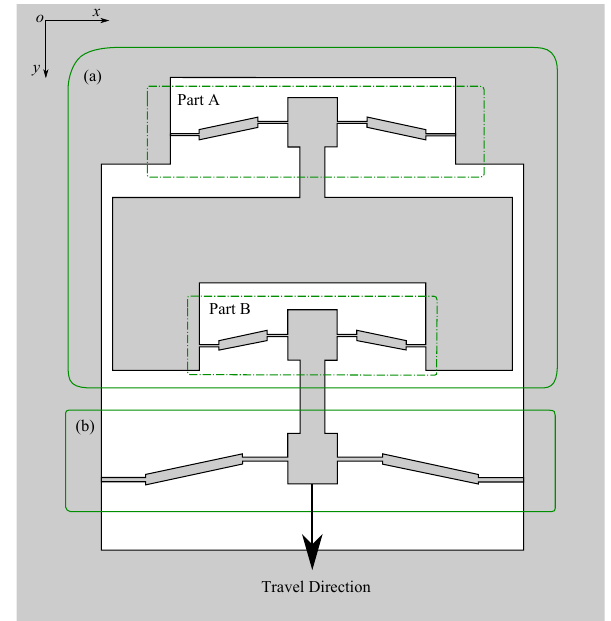
Figure 11. Structure of a fully-compliant statically-balanced mech- anism consisting of three classic fully-compliant bistable mecha- nisms. (a) The compliant tristable mechanism consisting of two fully bistable mechanisms (i.e., Part A and Part B), and (b) the bal- ancing bistable